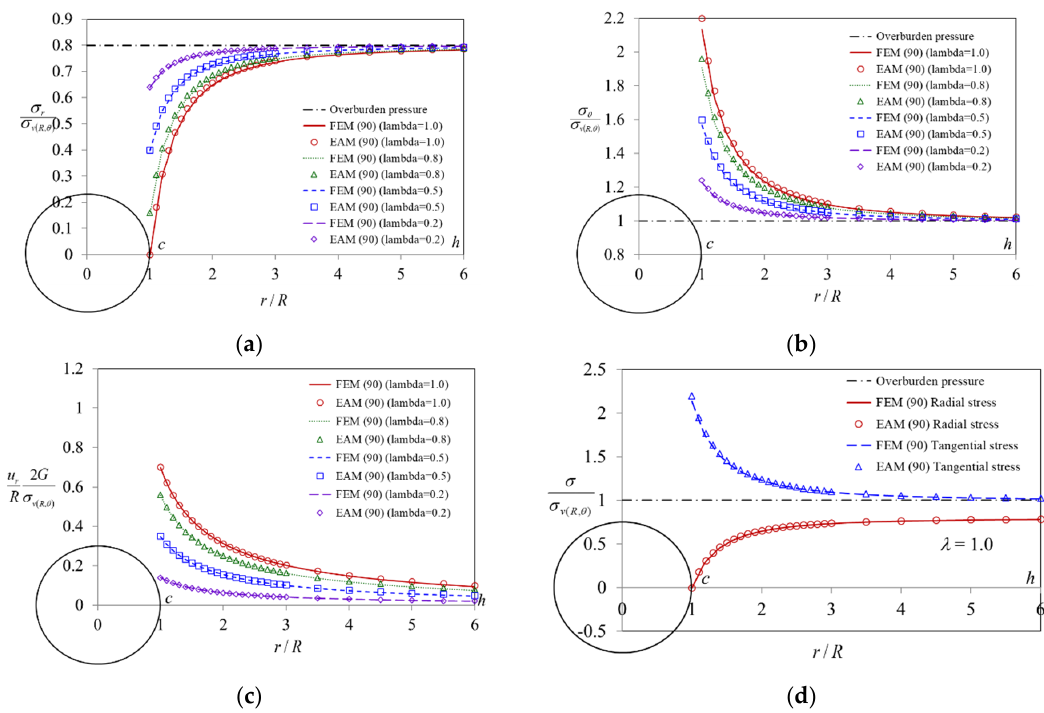
Figure 11. Ground reaction around the tunnel obtained by EAM and FEM with the different incre- mental values of λ in an elastic media, and the distribution of ( a ) radial stress, ( b ) tangential stress, ( c ) radial displacement, and ( d ) tangential and radial stresses with λ = 1.0 (Case II and K o = 0.8).